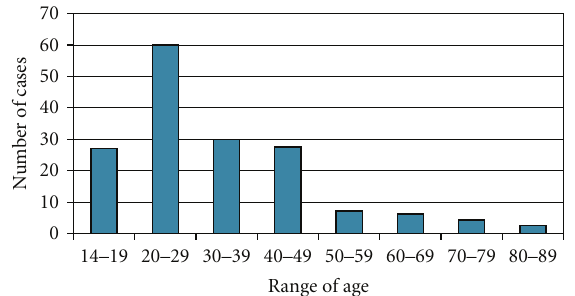
Figure 2: Diagnosed peritonsillar abscesses: Range of age in our 10- year series (1999–2009).